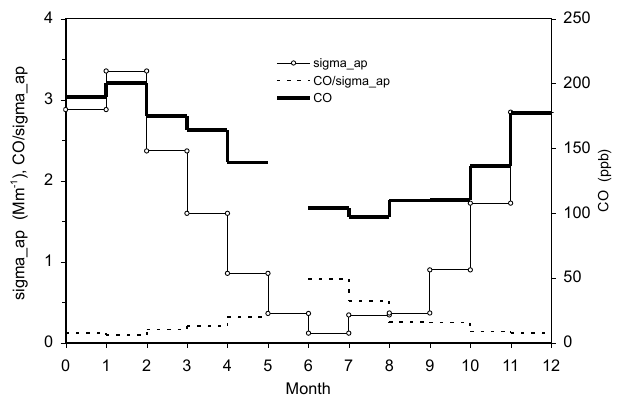
Fig. 5. Probability distribution of modal diameters of one-hour- median number size distributions taken at 50m and 300m height at ZOTTO (full lines). The size distributions were fitted with a max- imum of three lognormal modes in a range of 10–1000nm modal diameters. The dashed lines give median values of geometric stan- dard deviations as a function of geometric mean